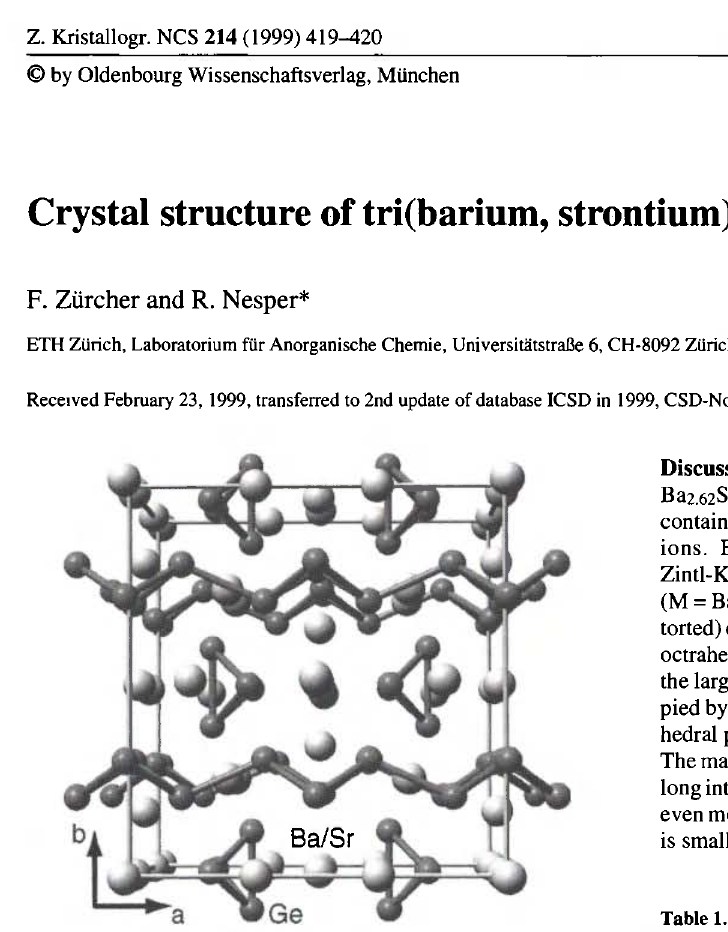
Table 1. Data collection and handling. Crystal: